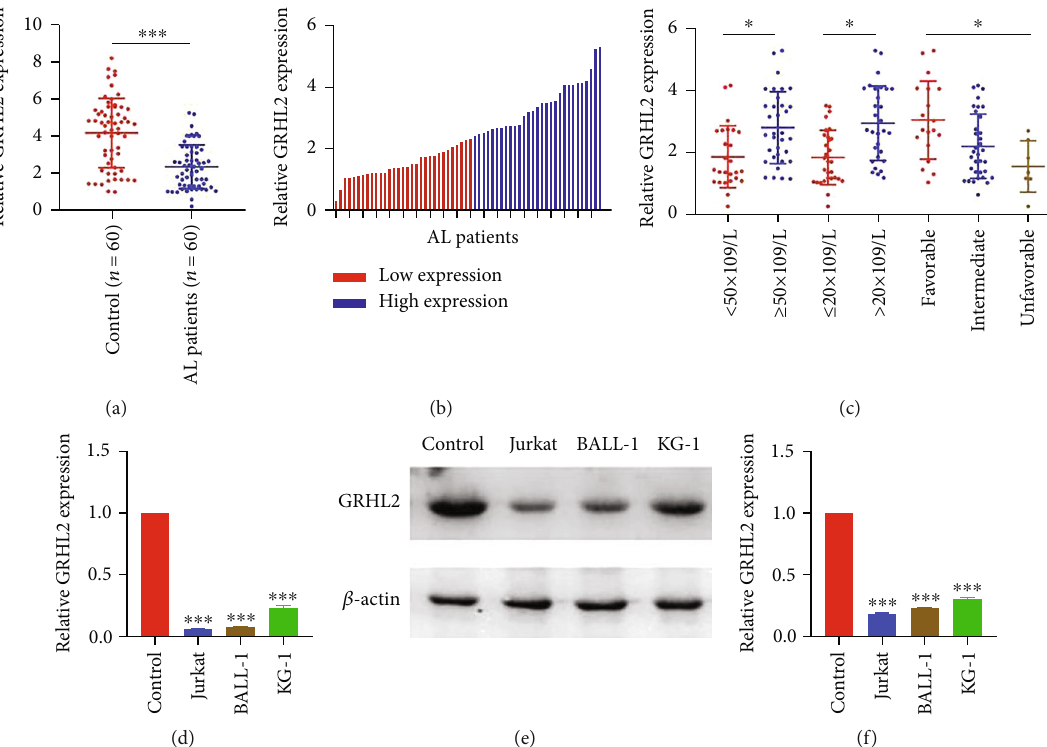
Figure 1: The expression of GRHL2 in patients with acute leukemia and cell lines. (a) The expression level of GRHL2 in patients with acute leukemia. (b) The low-expression group of GRHL2 (above mean) and the high-expression group of GRHL2 (below mean). (c) The expression level of GRHL2 and clinicopathological characteristics of patients with acute leukemia. (d) The mRNA expression levels of GRHL2 in acute leukemia cell lines KG-1, BALL-1, and Jurkat. (e, f) The protein expression levels of GRHL2 in acute leukemia cell lines KG-1, BALL-1, and